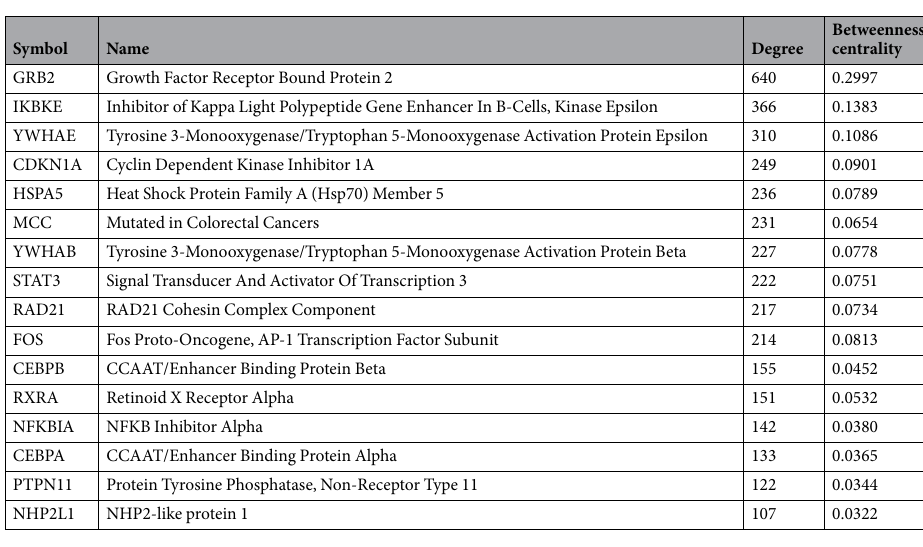
Table 1. Detailed information of the top 16 proteins by degree in CePPIN.